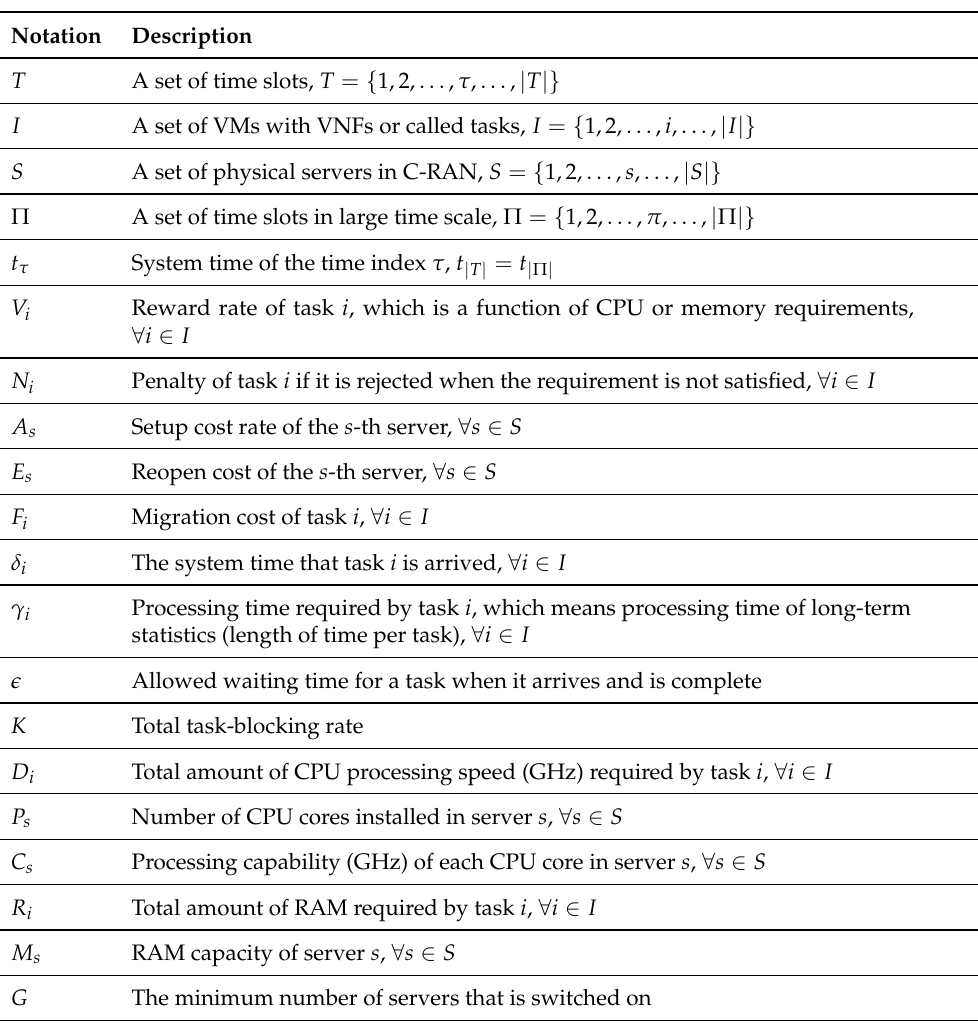
Table 2. Given parameters.